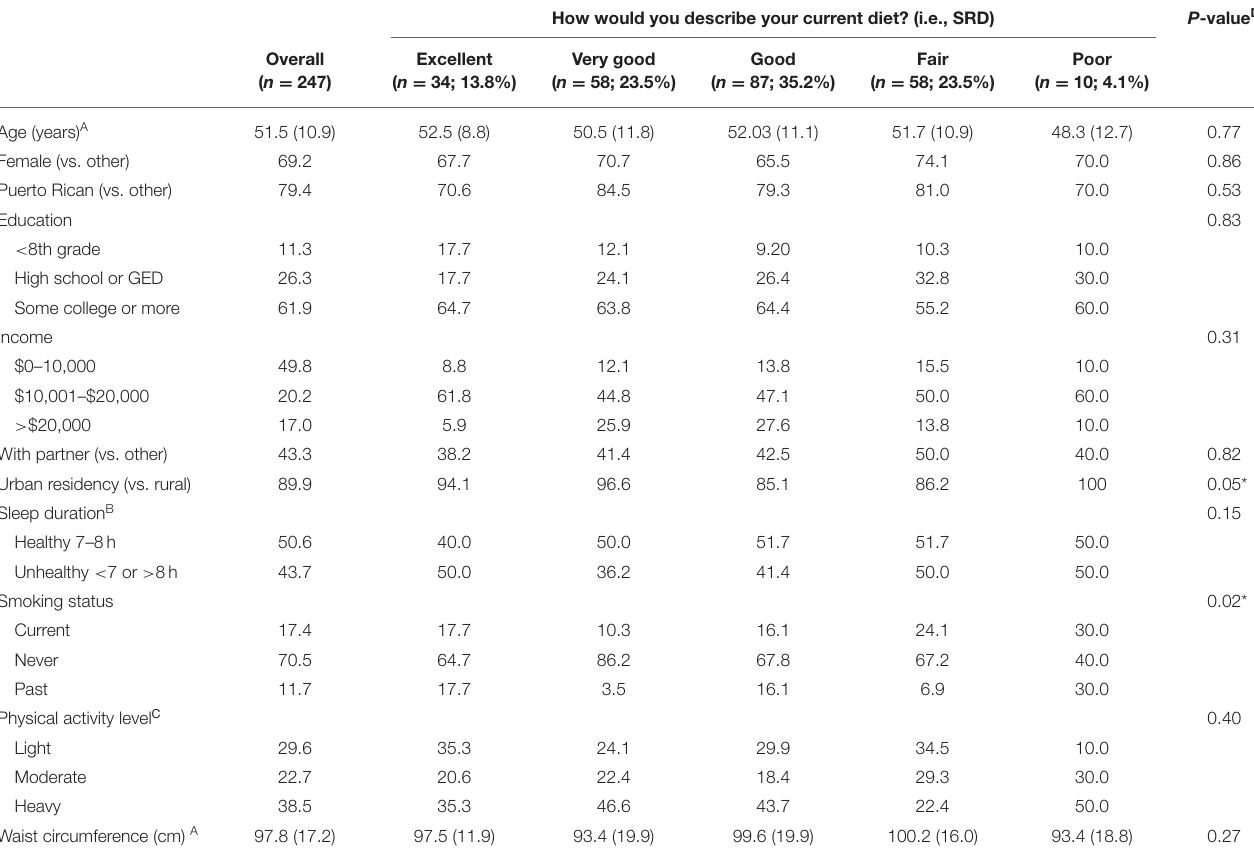
TABLE 1 | Characteristics of adults living in Puerto Rico, by self-reported diet quality on a five-point scale, 2015 ( n = 247). How would you describe your current diet? (i.e.,